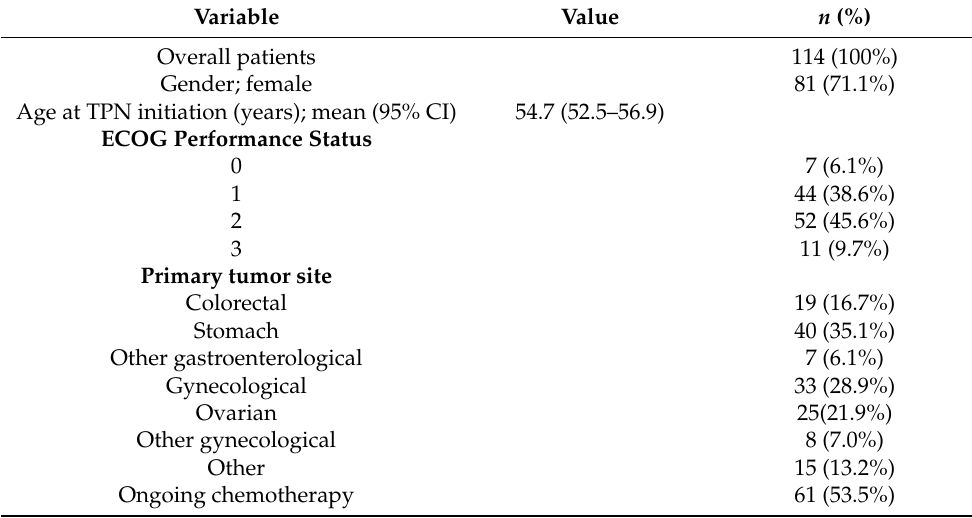
Table 1. Patient